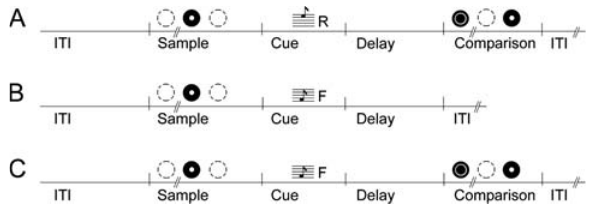
Figure 1. Behavioural Task Sequence of events on (A) remember trials, (B) forget trials, and (C) forget-probe trials. On remember and forget-probe trials the birds were presented with a test period, whereas on forget trials the test period was absent. The three horizontally arranged circles represent the projectors on which the stimuli, in this case a circle and dot, were displayed. During the cue and delay periods, the projectors were turned off. ITI, intertrial interval; R, remember cue, a high-frequency tone; F, forget cue, a low-frequency